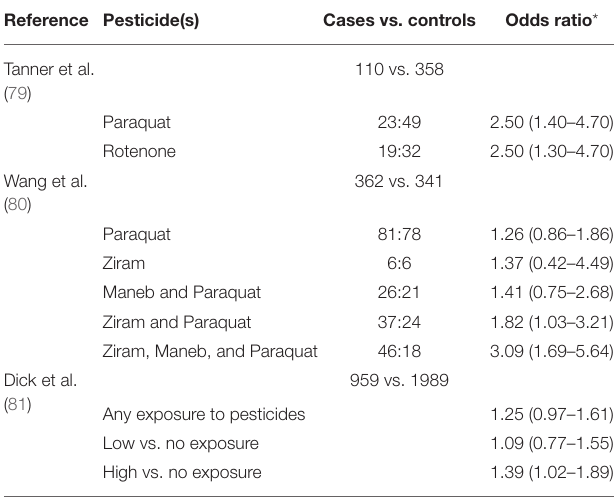
TABLE 1 | Risk factors of PD in the use of pesticides (with confidence interval of 95%). Reference Pesticide(s) Cases vs.